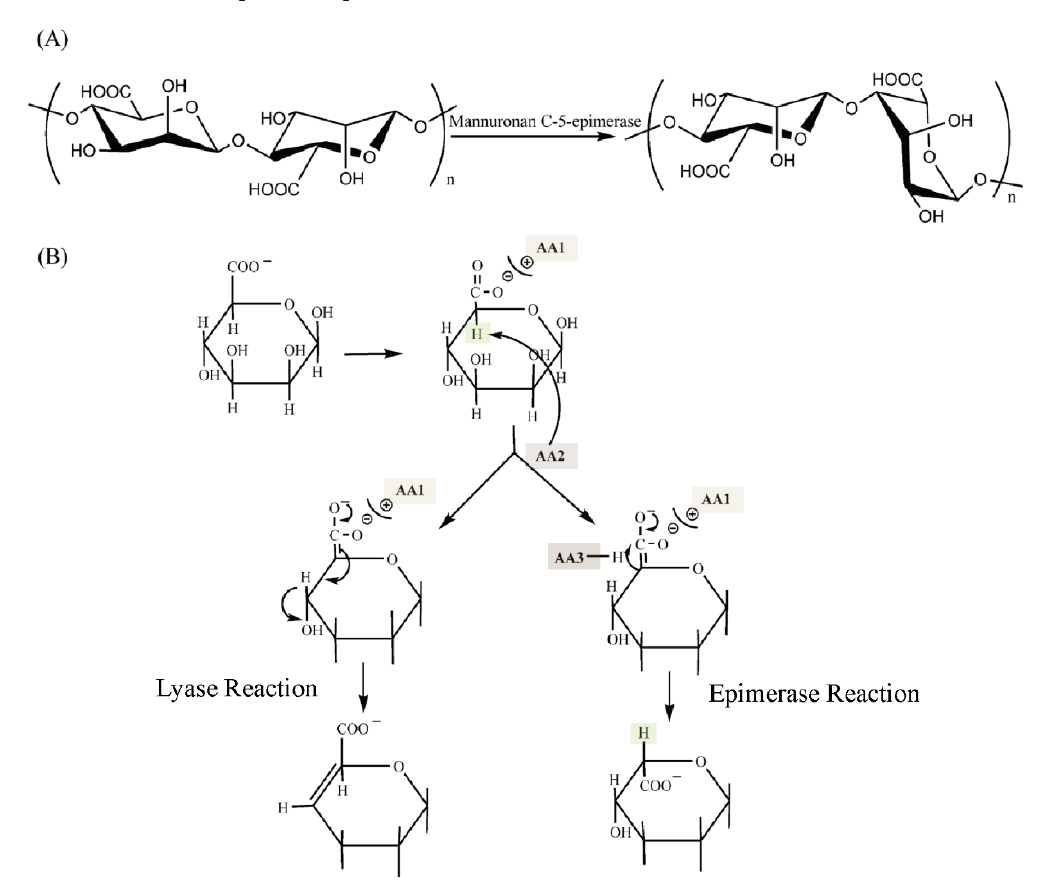
(Figure 5): (1) neutralization of the carboxylate group; (2) abstraction of the proton of the C-5; (3) either a β -elimination of the 4-O-glycosidic bond (the lyase reaction) or the re-